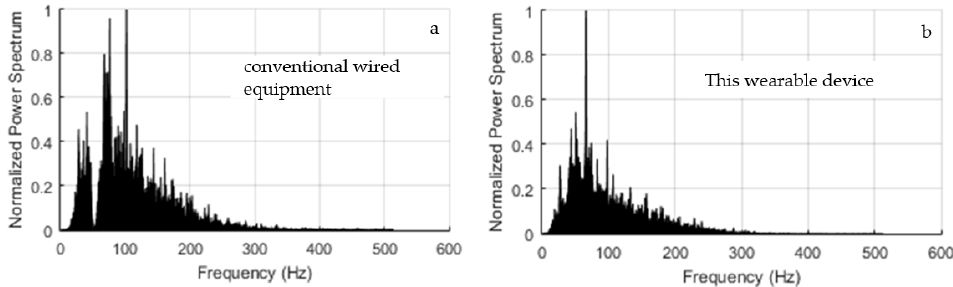
Figure 10. Normalized power spectrum of the sEMG signal during the contraction of the abductor pollicis brevis recorded by: ( a ) Digitimer D360 with Notch filter activated, ( b ) our wearable device.